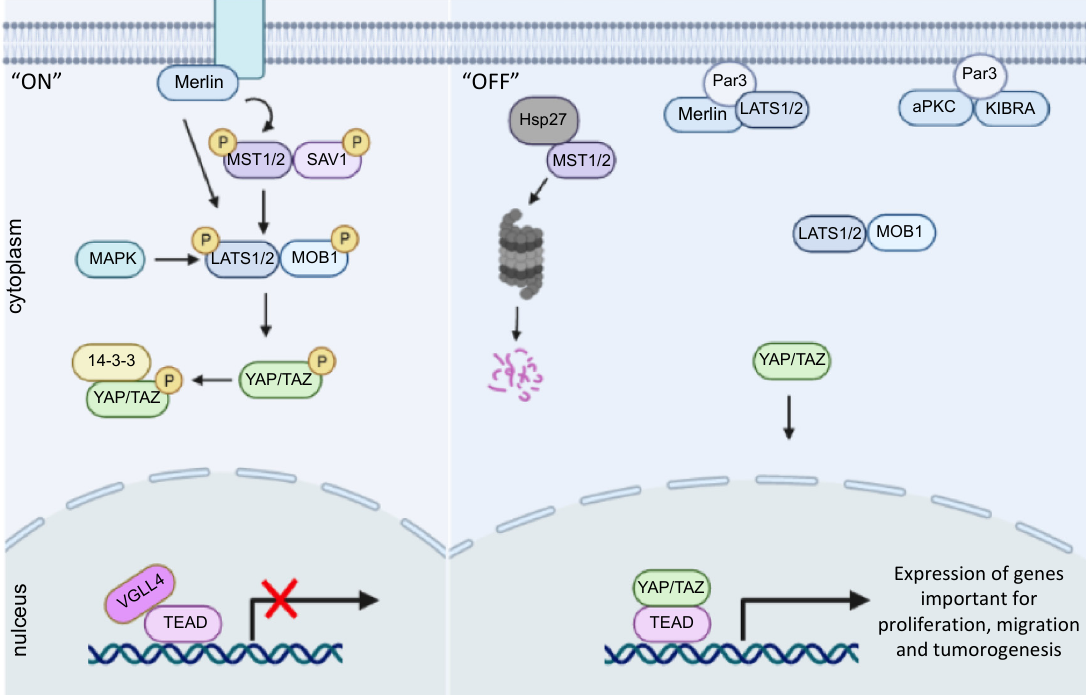
Figure 1. Hippo YAP/TAZ signaling pathway in early PCa. When the Hippo pathway is switched ON, phosphorylation of Mst1 and Lats1 by Merlin and MAPK leads to phosphorylation of YAP/TAZ that forms a complex with 14–3–3 protein in the cytoplasm. VGLL4 binds to TEAD binding promoters thus, blocking the expression of genes important for proliferation, migration and tumorigenesis. In the OFF condition, in early prostate tumor cells, Lats1/2 is dephosphorylated due to various mechanisms such as degradation of Mst1/2 by Hsp27, complex formation of Lats1/2 with Par3 and Merlin and dissociation of Lats1/2 and KIBRA complex by Par3. Due to blocking of physiological kinase cascade of the Hippo pathway, unphosphorylated YAP/TAZ enters the nucleus and act as co-regulator of TEAD transcription factors leading to expression of target genes.